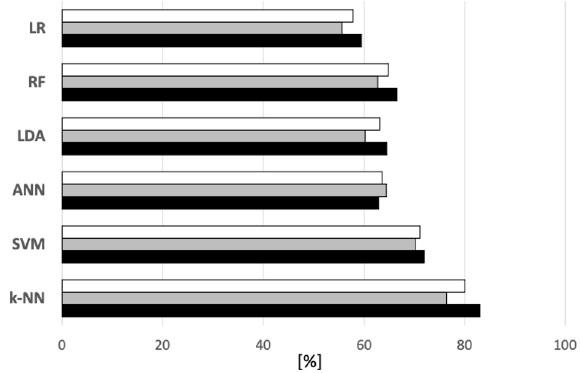
Figure 8. F1-score (White), Recall (Grey) and Precision (Black) for the best performance of each classifier— cross-subject.